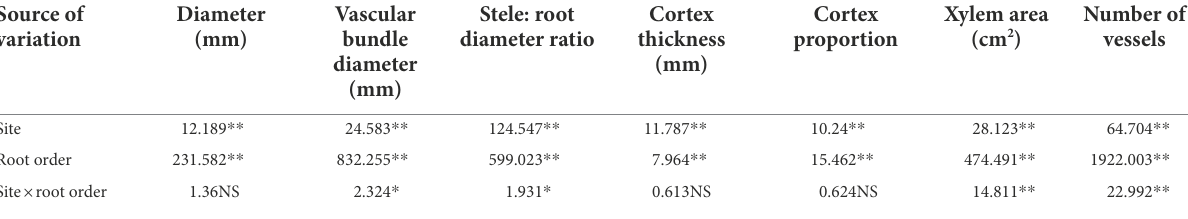
TABLE 2 Variance analysis of the influence of site and roots order on the anatomical structure of fine roots.